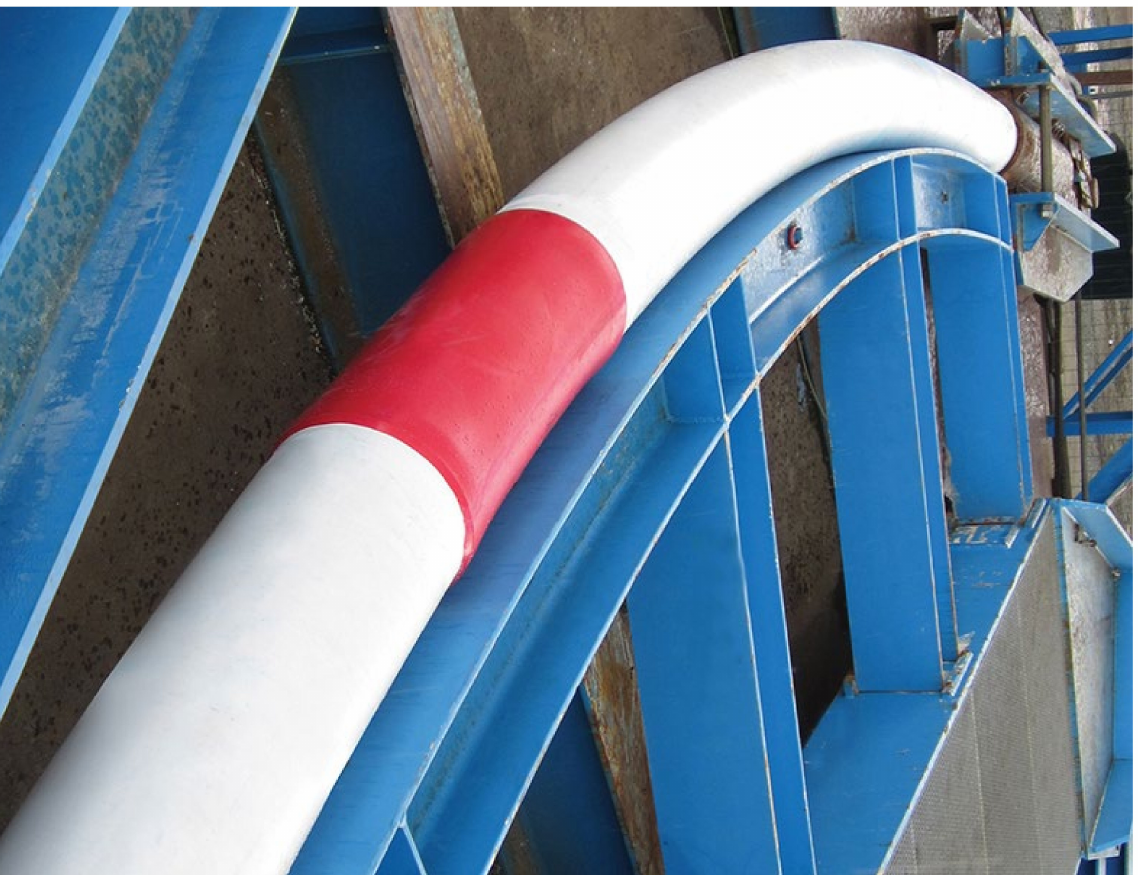
Figure 2. Typical example of a reeled system during a bend test for validating reeling capability after coating by Bredero Shaw. (Permission obtained from World Pipelines and Elizabeth Corner. Source: Corner E.